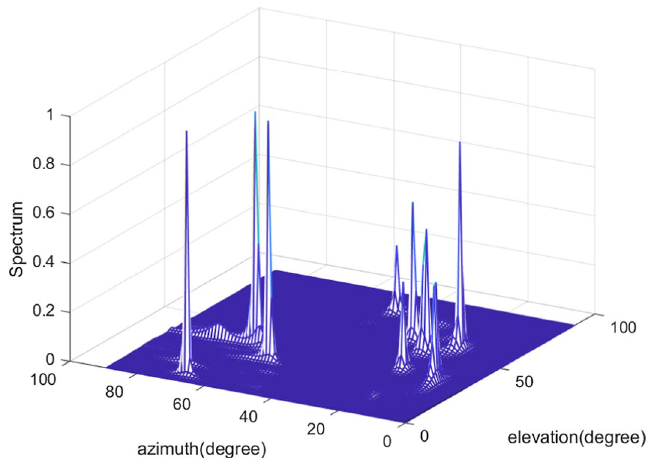
Fig. 9 2D MUSIC spectrum of the extended sparse conv array (2, 3), SNR